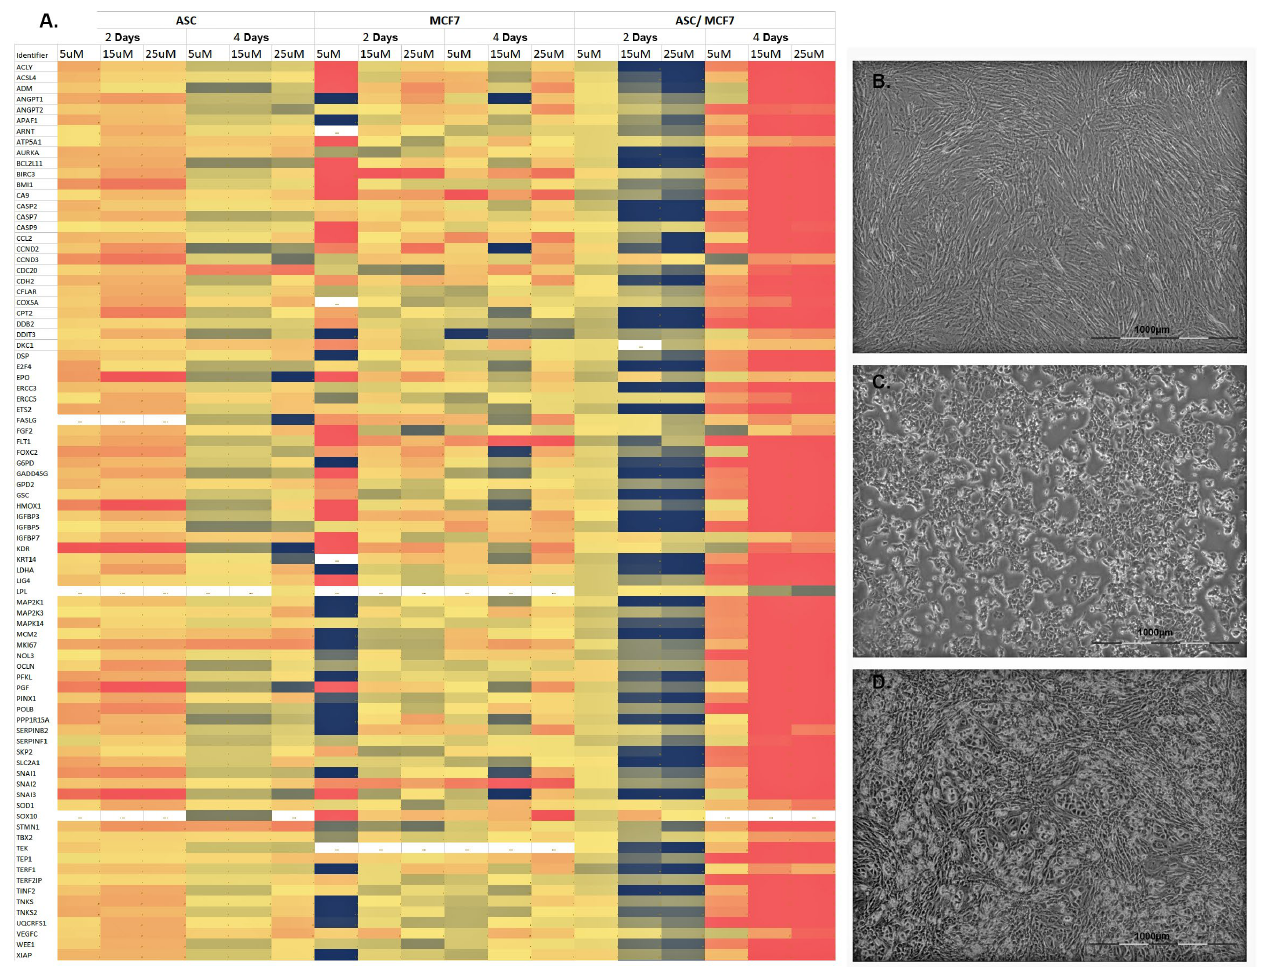
Figure 3. Gene expression of the examined genes of the PCR arrays of ASC, MCF-7 cells and corresponding co-cultures. ( A ) From left to right, ASC, MCF-7 cells and co-culture were each treated with 5 µ g, 15 µ g or 25 µ M tamoxifen for 48 or 96 h. The color coding (see Figure 2) indicates a relative increase (black) or reduction (red) in gene expression. The 84 genes studied and their associated pathways in tumorigenesis and transformation are listed in Table 1. ( B ) ASC of passage 2 after treatment with 25 µ M tamoxifen after 96 h in culture. ( C ) MCF-7 cells of passage 32 after treatment with 25 µ M tamoxifen after 96 h in culture. ( D ) Co-culture of ASC and MCF-7 cells after treatment with 25 µ M tamoxifen after 96 h in culture.